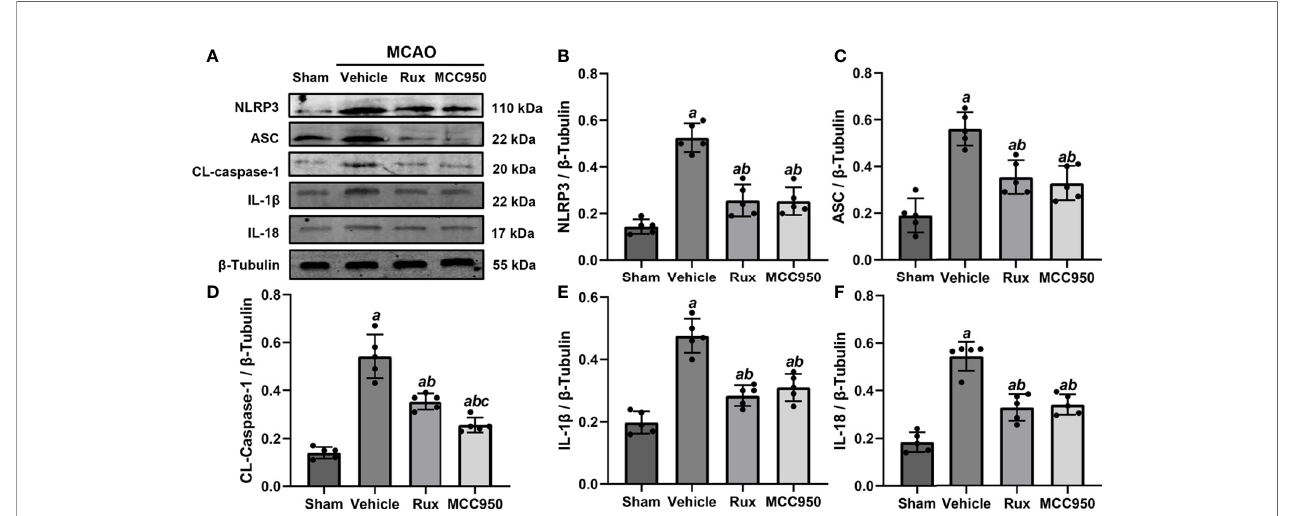
FIGURE 4 | Rux treatment suppressed NLRP3 in fl ammasome-associated proteins. (A) Representative western blots showing that administration of Rux reduced the expression of NLRP3, ASC, CL-caspase-1, IL-18 and IL-1 b in the peri-ischemic region 3 days after MCAO. (B – F) Quanti fi cation results of NLRP3, ASC, CL- caspase-1, IL-18 and IL-1 b protein levels in the ischemic cortex. Means ± SD. n = 5/group. a P < 0.01 versus sham; b P < 0.01 versus vehicle; c P < 0.05 versus